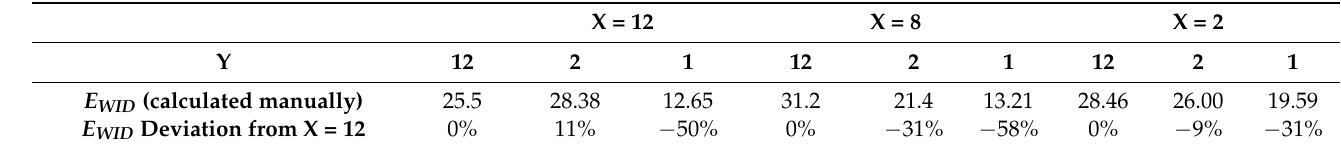
Table 3. An example of manually calculated background luminance for different room widths while the length also is changing. X = 12 X = 8